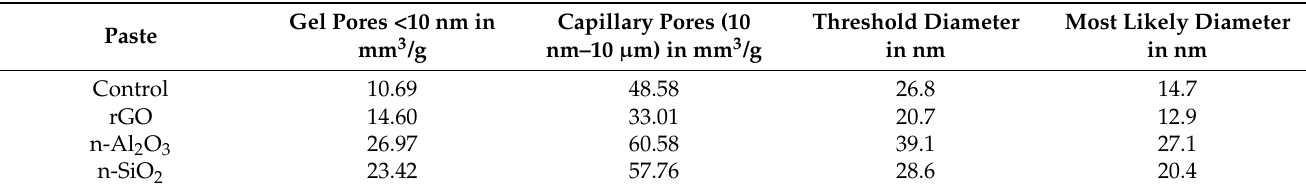
Table 2. Pore structure feature of rGO-reinforced cement paste. Reprinted with permission from Ref. [102]. Copyright 2016 Elsevier.